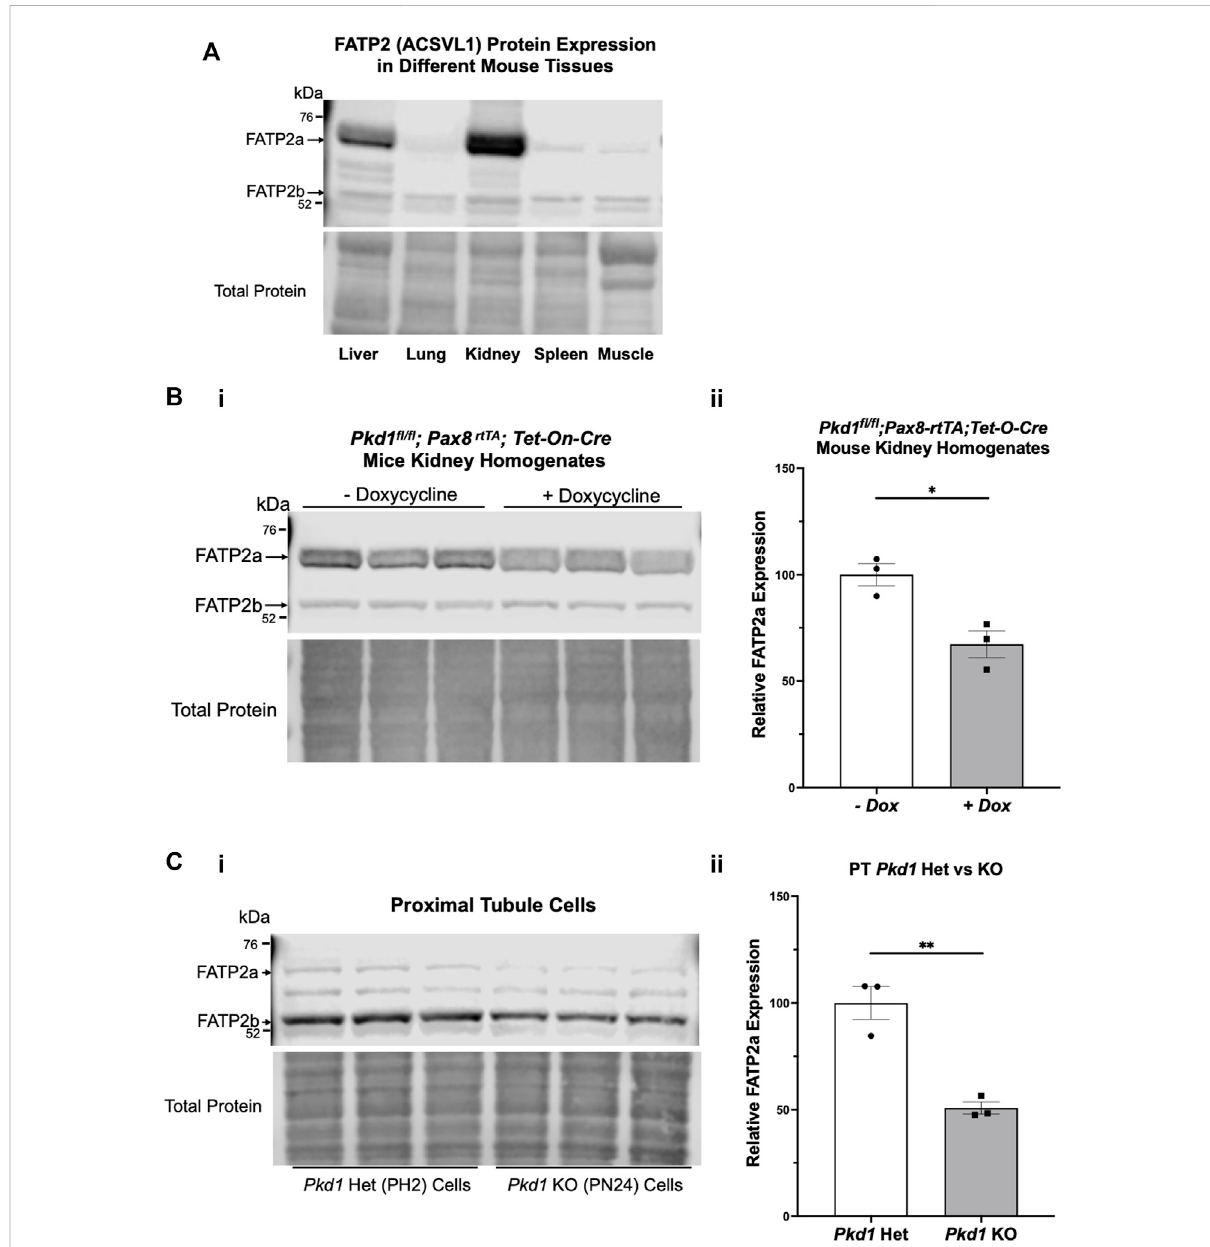
The bempedoic acid-activating enzyme ACSVL1 (FATP2) is expressed in different mouse tissues and PKD kidneys and kidney cell lines. (A) . Upper,immunoblottingofvariousmousetissuesrevealsexpressionoftwodistinctFATP2isoforms.Theshortsplicevariant(FATP2b),whichlacksthe acyl-CoAsynthetasedomainrequiredforconversionofBAtoitsactivemetaboliteBA-CoA,isexpressedinalltissuestested.However,thefull-length long form (FATP2a at ~70 kDa) has signi fi cant expression only in liver and kidney tissue, thus providing speci fi city of BA pro-drug conversion to its active form only in these tissues. Lower, staining for total protein as a loading control. (B) FATP2 immunoblotting of representative Pkd1 fl / fl ;Pax8- rtTA;Tet-O-Cre mouse kidneys treated with or without doxycycline to induce tubule-speci fi c Pkd1 gene inactivation at P10-P11. i Upper, the immunoblotrevealed expressionofFATP2ainallmousekidneysatthetime ofeuthanasia(P22).Lower,stainingfortotalproteinasaloadingcontrol. ii Densitometric analysis of the FATP2a band normalized to total protein revealed a ~35% reduction of the expression of the active enzyme in Pkd1 - null mouse kidneys (* p < 0.05). (C) Both FATP2a and FTAP2b isoforms are also expressed in immortalized mouse kidney epithelial cells that were derived from PT. i Upper; We observed generally lower FATP2a expression in Pkd1 KO cells (right) than in controls (left). Lower, staining for total protein as a loading control. ii. Densitometric quanti fi cation of the FATP2a levels, normalized to total protein indicates that the Pkd1 -null PT cells express approximately 50% less FATP2a than the heterozygous Pkd1 +/ − cells (** p < 0.01). Three representative lysate immunoblots are shown for each